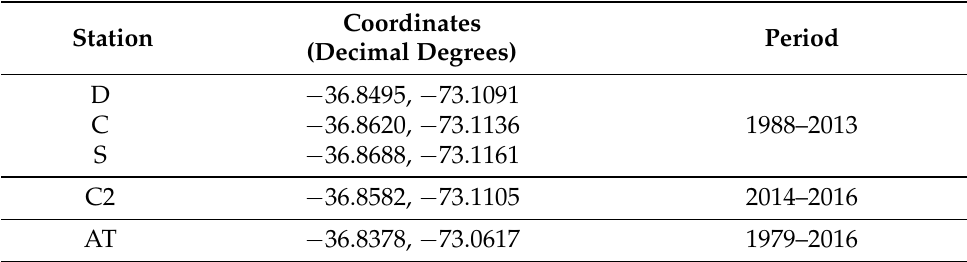
Figure 2. LSWT available data in sampling stations: Desagüe (WT D), Centro (WT C), Sur (WT S) and Centro 2 (WT C2). Air temperature near study area (AT). Table 2. Available LSWT sample stations: Desagüe (D), Centro (C), Sur (S) and Centro 2 (C2). Seasonal samplings: 4 per year. (I) Used sample stations: D, C and S. Available data: LSWT in the period 1988–2013, 28% of missing data. Used data: LSWT in the period 2000–2009, 7.5% of missing data. (II) Centro 2 sample station: available LSWT data in the period 2014–2016, 75% of missing data. Available air temperature station: AT. Available data: mean daily temperature in the period 1979–2016, 0% of missing